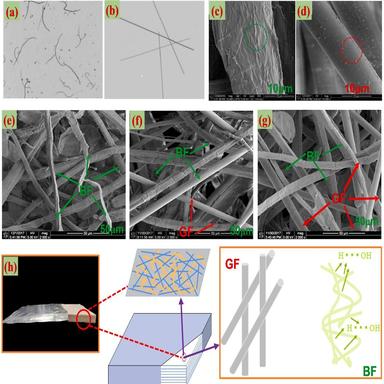
(a, b) Optical microscope morphology and (c, d) SEM morphology of BF and GF; SEM morphology of composite core materials with various GF proportions: (e) BGF0, (f) BGF30, and (g) BGF50; (h) Lab made VIP image and the corresponding structure diagram of the core material.